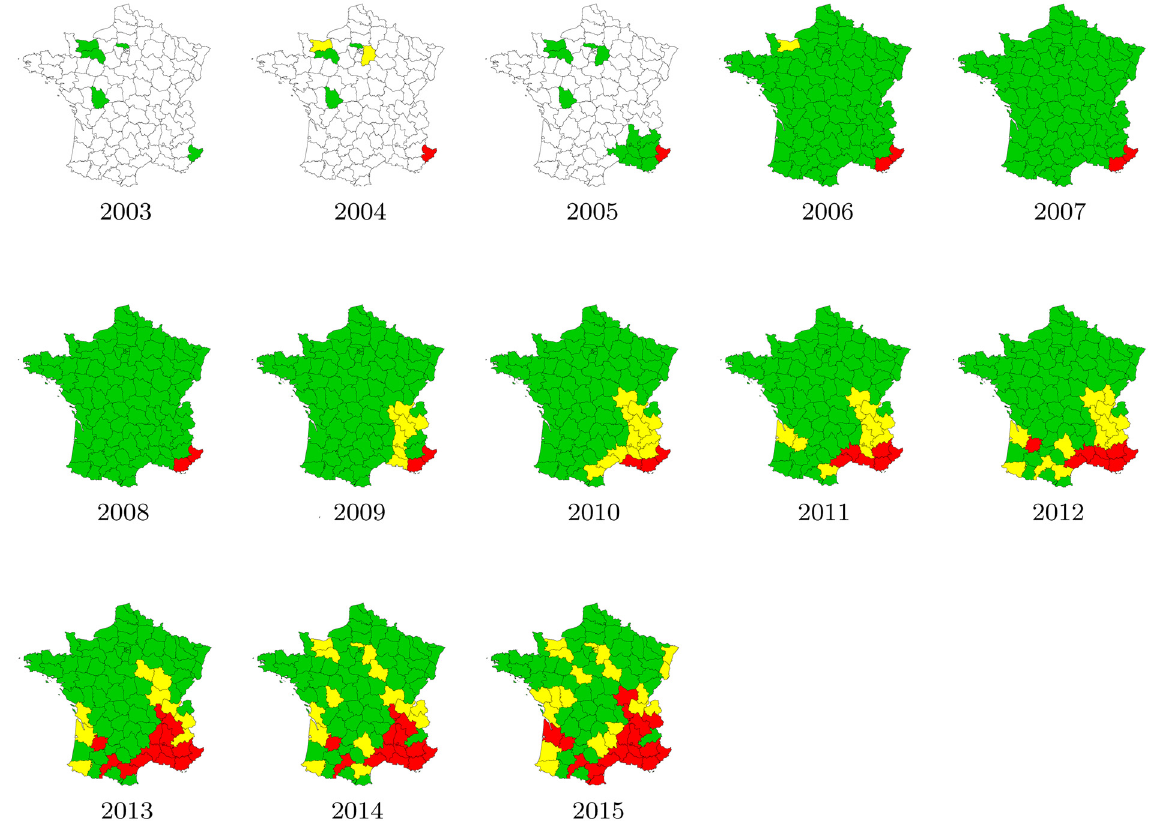
Fig 3. Distribution of A. albopictus in mainland France between 2003 and 2015. The mosquito was considered as absent in the green departments, introduced (few individuals detected) in yellow departments, and established in red departments. Before 2006, some departments were not monitored (white departments). Source: French Interdepartmental Agreement for Mosquito Control (2003 – 2011 data), and European Centre for Disease Prevention and Control (2012 – 2015